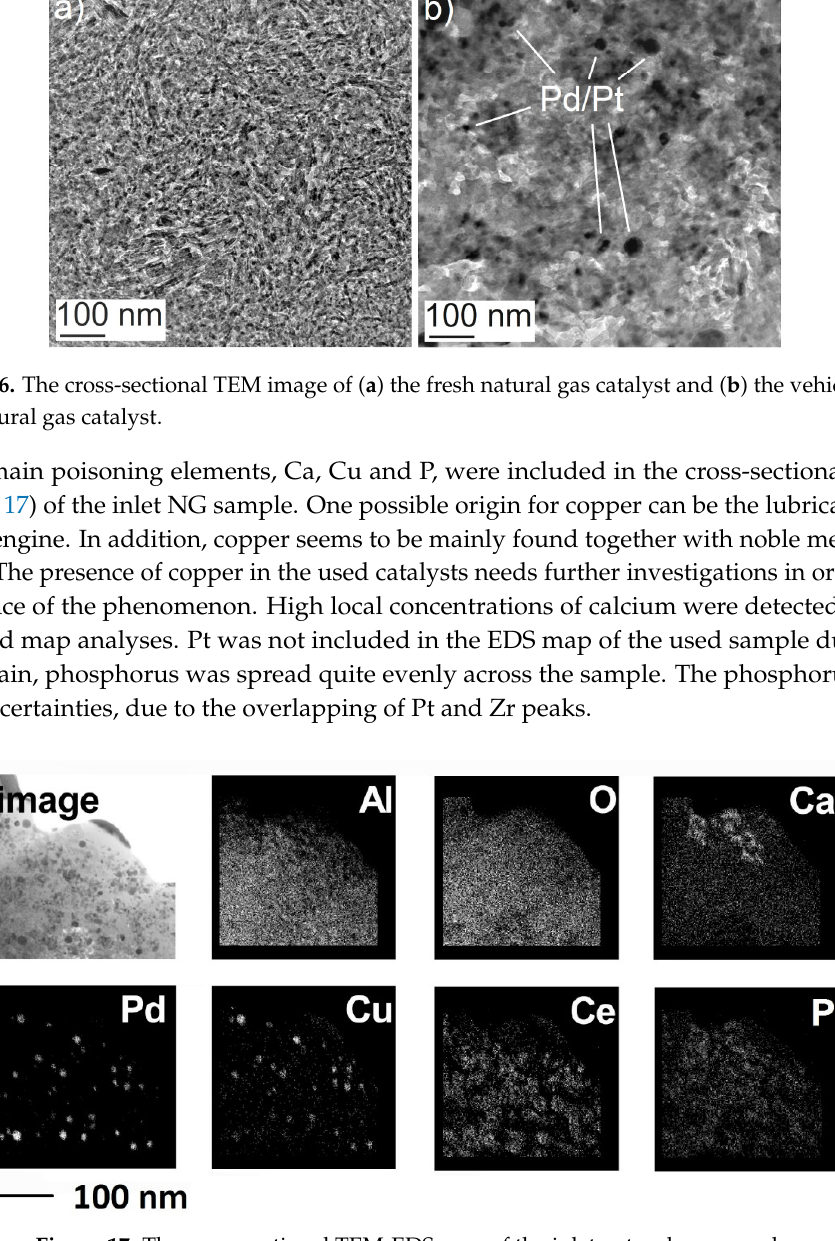
Figure 15. TEM images from the vehicle-aged natural gas catalyst ( a ) inlet, ( b ) outlet.